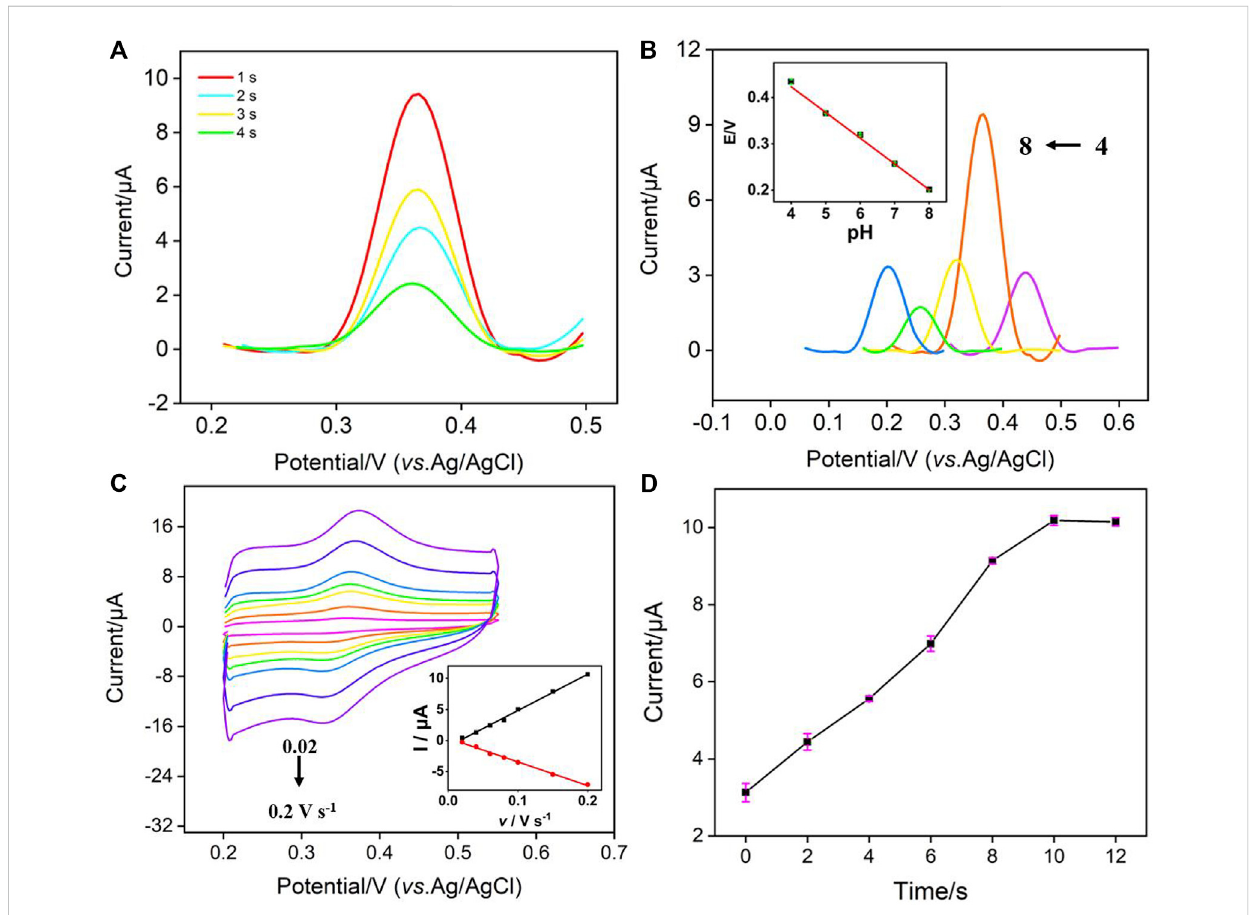
FIGURE 4 (A) DPV curves of NE on AuNPs@NH in-situ preparation of AuNPs. (B) DPV 2 -VMSF/p-GCE prepared using different electrodeposition time for the curves of NE (10 μ M) at different pH. Inset the relationship between E and pH. (C) CV curves on AuNPs@NH 2 -VMSF/p-GCE in NE solution (10 μ M) with different scan rates. Inset is the plots between peak current and scan rate. (D) The peak current obtained on AuNPs@NH 2 -VMSF/p-GCE at different accumulate time. The error bars represent the relative standard deviation (RSD) of three